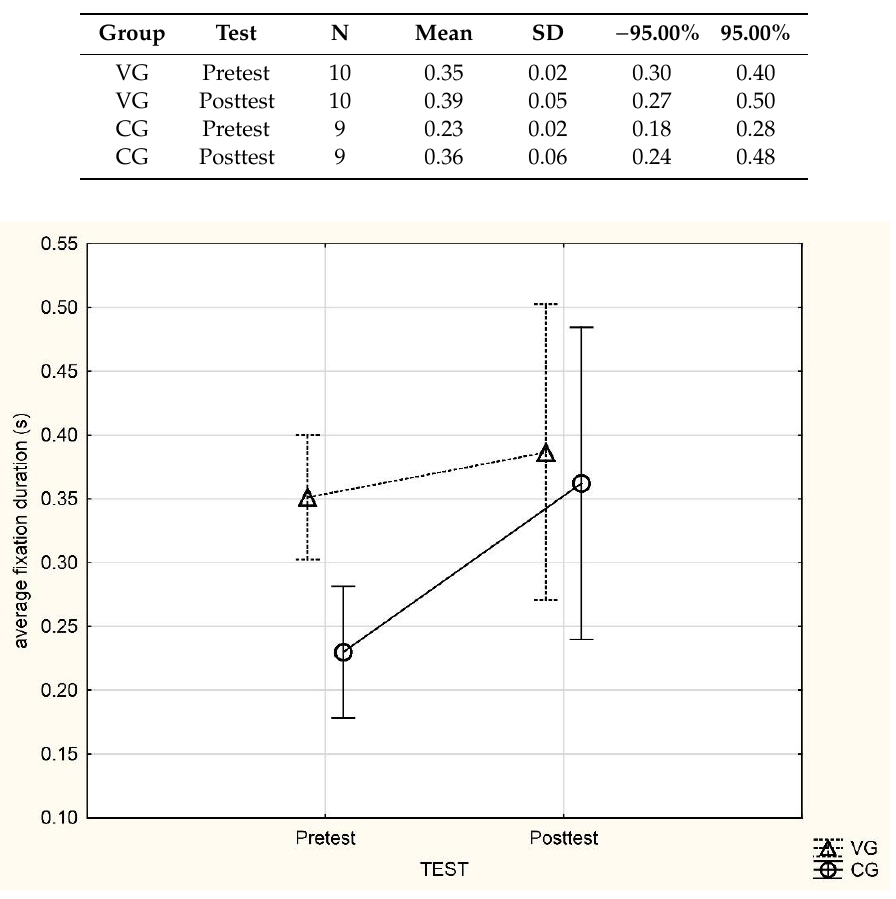
Figure 2. The changes in average gaze duration between pre- and posttest in a variable group (VG) and constant group (CG) practice conditions group.